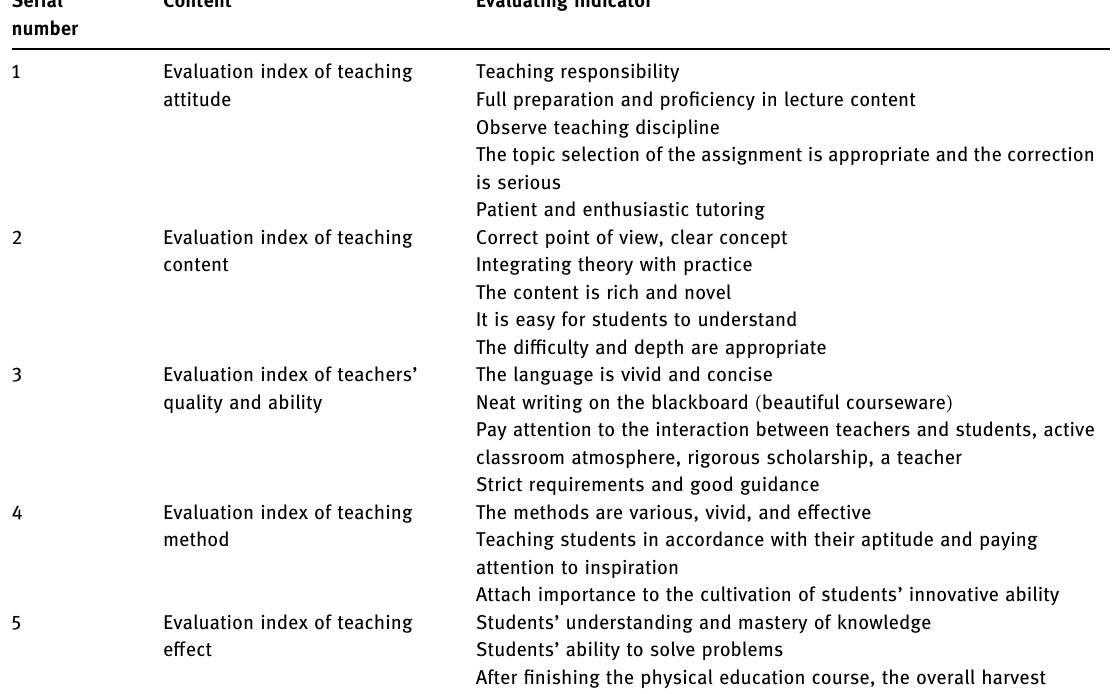
Table 1: Evaluation index of physical education teaching quality